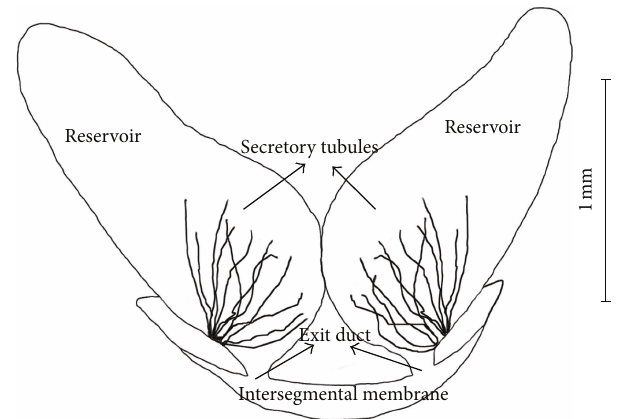
Figure 2: Line diagram of defensive gland of Mesomorphus villiger.